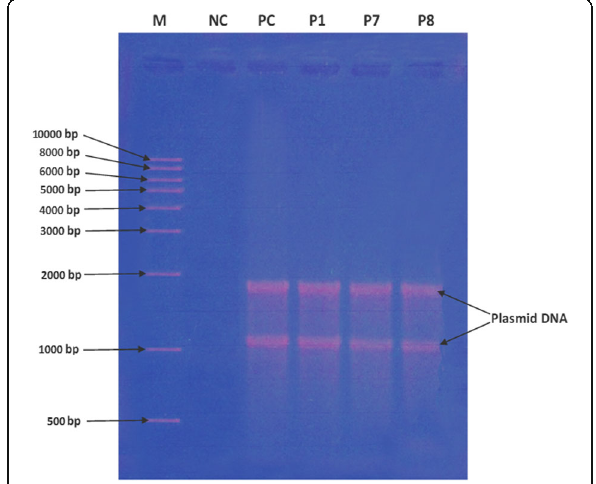
Fig. 3 Plasmid profiles of the multiple antibiotic-resistant (MAR) P. aeruginosa isolates (lane M denoted size marker of 500 – 10,000 bp, lanes NC and PC denoted negative and positive control, respectively, lanes P1, P7, and P8 were P. aeruginosa isolates have two plasmids of sizes between 1000 and 2000